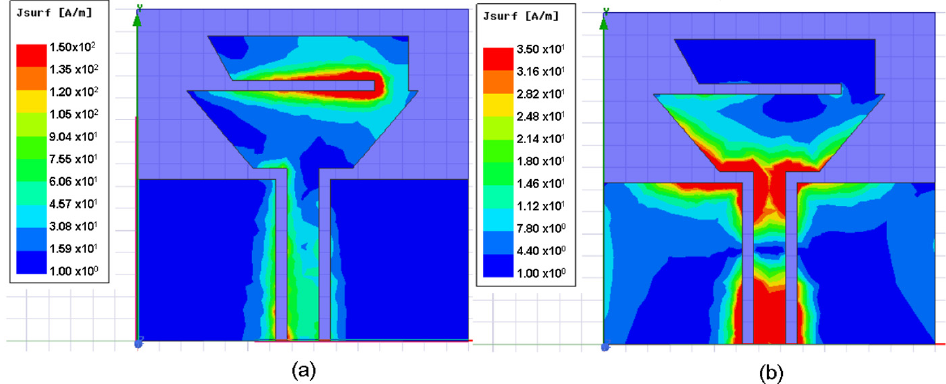
Figure 9. Simulated current distribution at ( a ) 2.45 GHz and ( b ) 5.8 GHz.